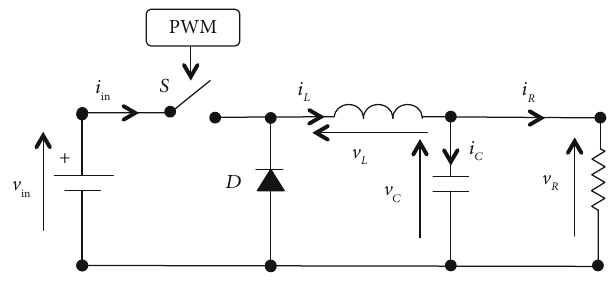
Figure 7: Buck converter architecture.